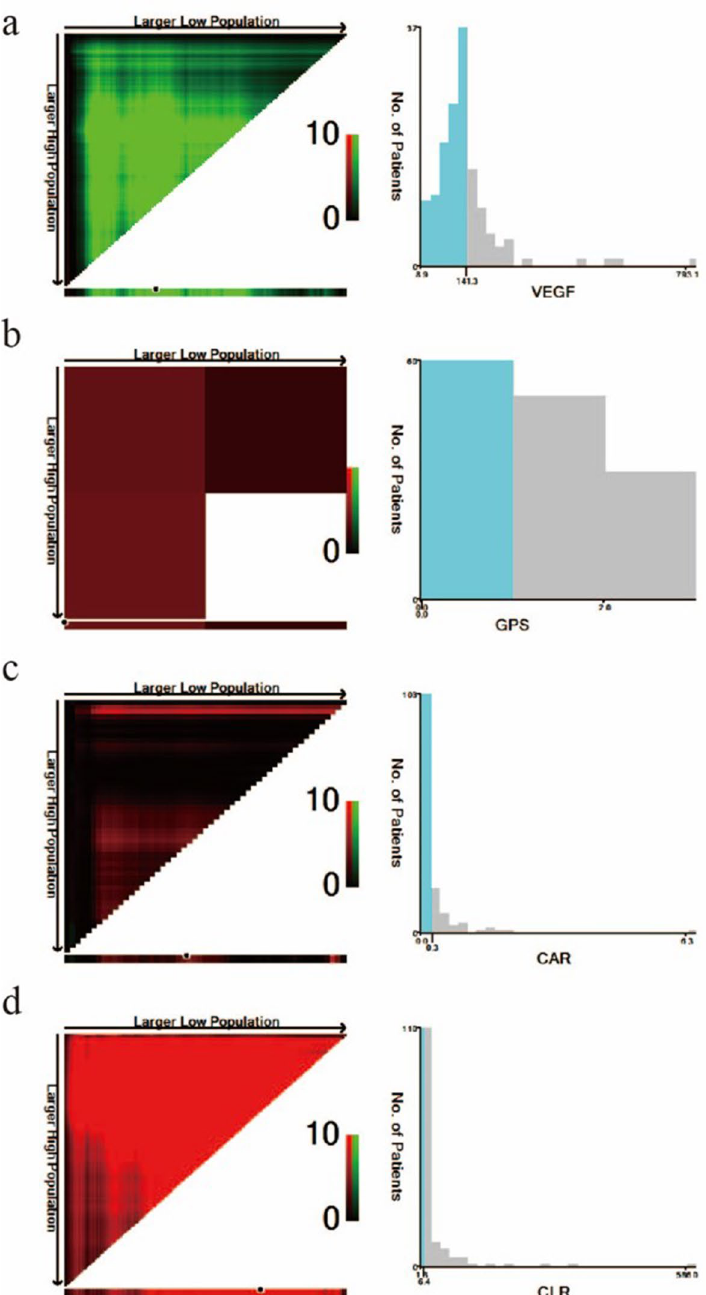
Figure 3. 4 X-tile analysis of PFS was performed by the X-tile program to determine the optimal cutoff values for VEGF, GPS, CAR, and CLR. The sample of ESCC patients was equally divided into training and validation sets. X-tile plots of training sets are shown in the left panels, with plots of matched validation sets shown in the small inset. The optimal cut-off values highlighted by the black circles in the left panels are shown in histograms of the entire cohort (right panels). p values were determined by using the cutoff values defined in training sets and applying them to validation sets. The optimal cutoff values for VEGF, GPS, CAR, and CLR were 141.3, 0, 0.3, and 6.4, respectively. ( a ) VEGF, ( b ) GPS, ( c ) CAR, and ( d )